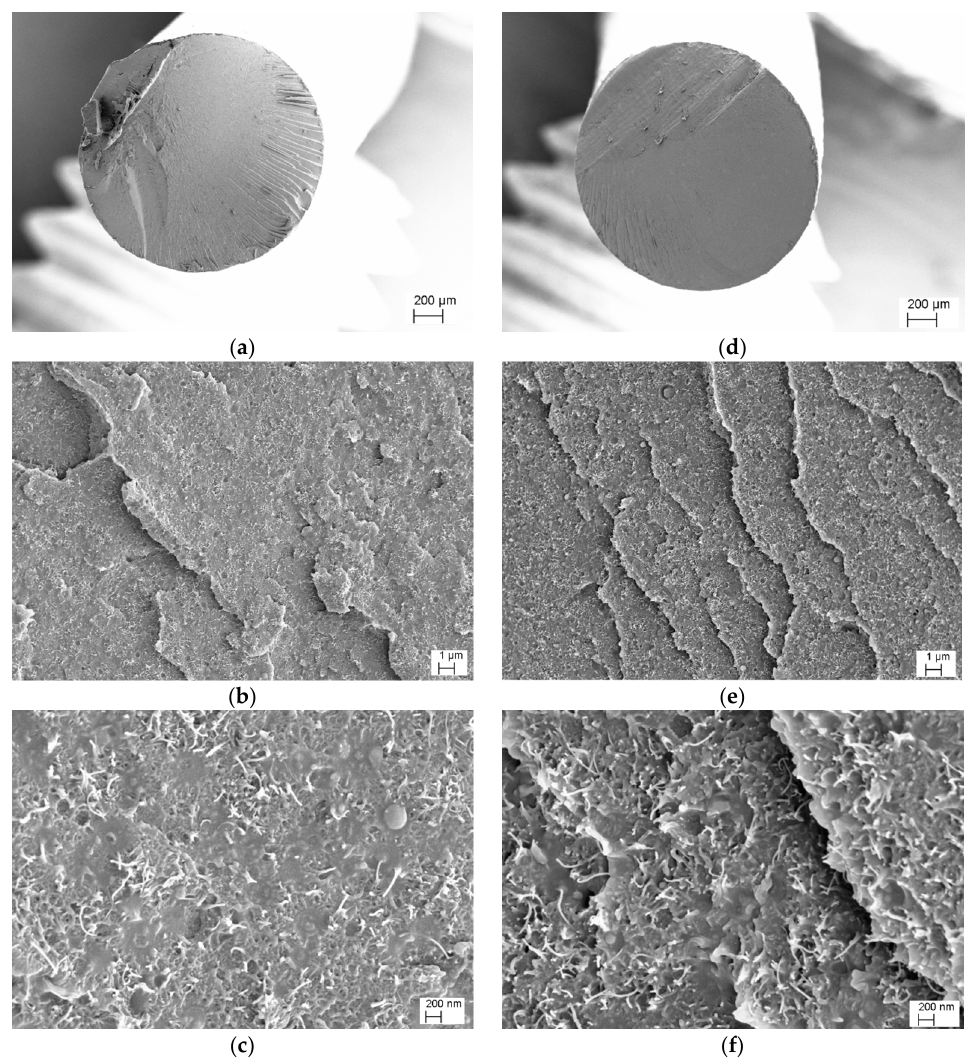
Figure 4. FESEM micrographs of CNT6 ( Left ) and CNT8 ( Right ) filaments at different magnifications ( a , d ) ×80, ( b , e ) ×10,000 and ( c , f ) ×50,000. Carbon nanotubes are identified in the form of small white lines in the highest magnification images.